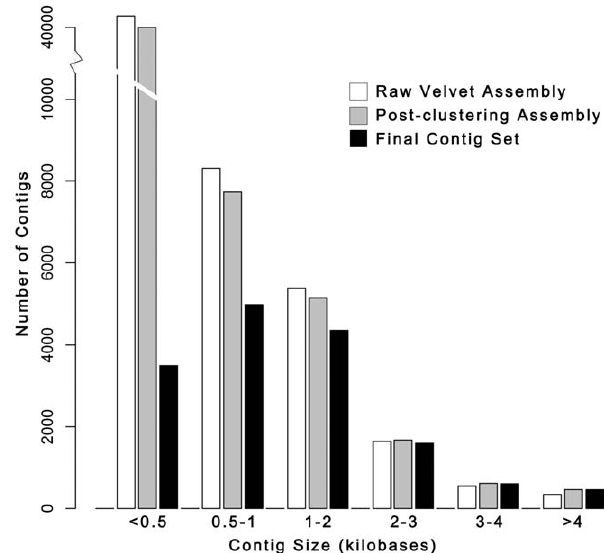
Figure 2. Size distribution of contigs at three points of the assembly. Note that the y-axis is broken between 10,000 and 40,000. White bars indicate the size distribution of contigs generated by the iterative Velvet assembly. Grey bars indicated the size distribution of contigs after ‘target-based’ clustering to both An. funestus ESTs and An. gambiae peptides. Black bars indicate the size distribution of the final contig set after quality filtering and bioinformatic analysis. The final contig set contains 15,527 contigs with an N50 of 1,753